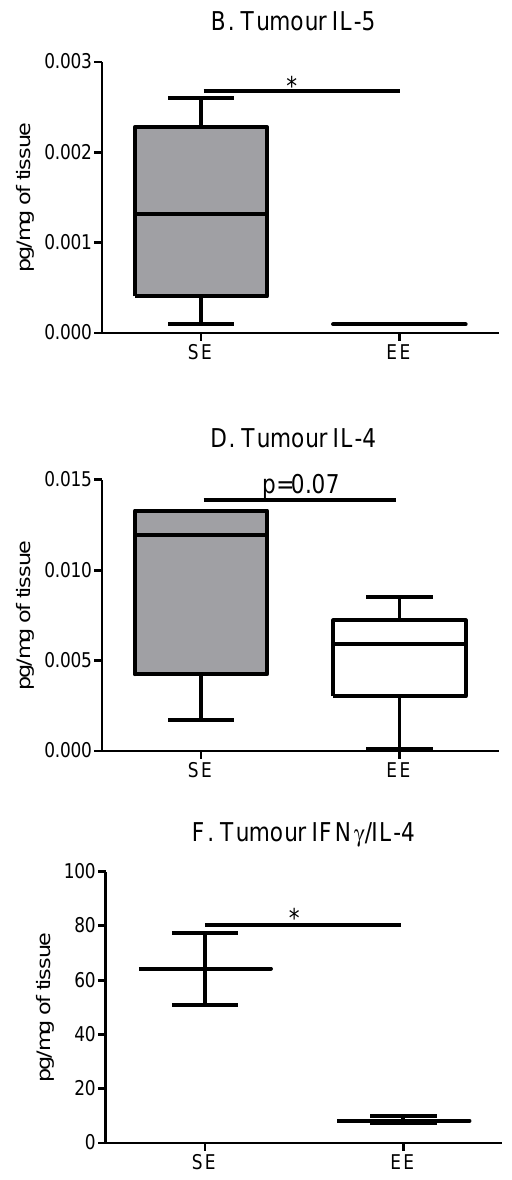
Figure 6. Spontaneous physical activity induces an immune anti-inflammatory microenvironment in the tumours. ( A ) Tumour lymphocytes T-helper infiltrate, results are in cells per mg of tumour. ( n = 5 mice tumour phenotyping analysis/group) ( B ) Quantity of IL-5 in tumour, results are in pg/mg of tissue. ( C ) Quantity of IL-6 in tumour, results are in pg/mg of tissue. ( D ) Quantity of IL-4 in tumour, results are in pg/mg of tissue. ( E ) Quantity of IFN- γ in tumour, results are in pg/mg of tissue. ( F ) Ratio of IFN- γ /IL-4 in tumour, results are a ratio of IFN- γ (in pg/mg of tissue) divided by IL-4 in (in pg/mg of tissue). Cytokine determination is performed on 5 mice tumour samples/group. Data are mean ± SEM. Data were analysed by Mann–Whitney t -test. Representative data are shown: * p < 0.05, SE vs. EE.